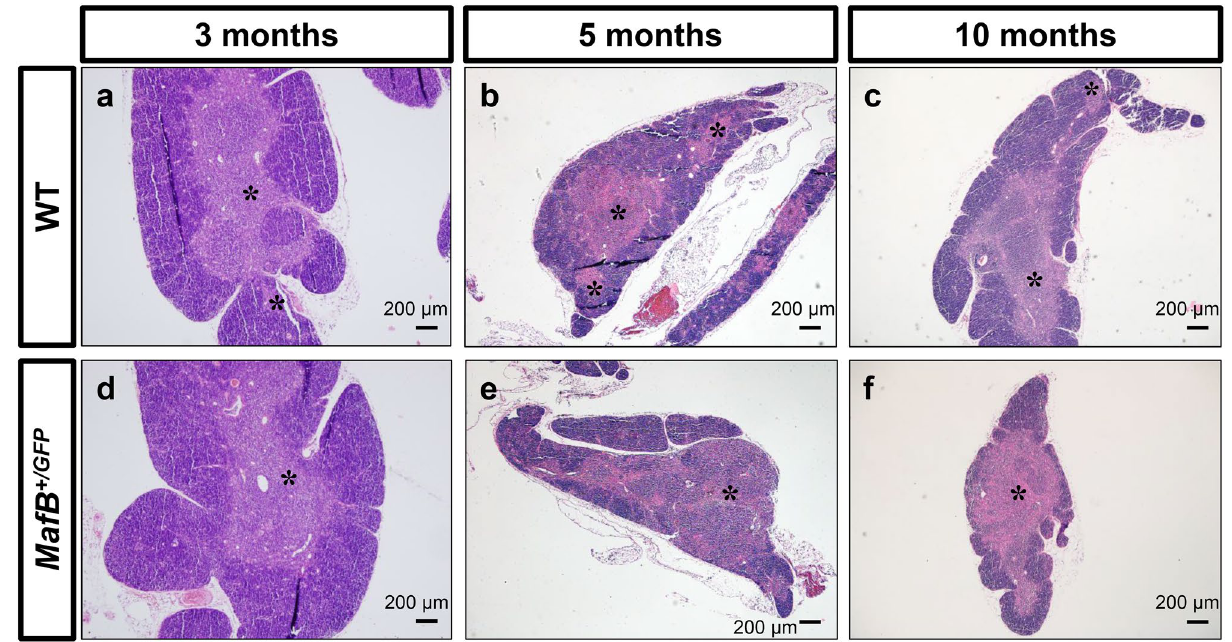
Figure 7. MafB + /GFP mice showed signs of accelerated age-related thymic involution. ( a – f ) Hematoxylin and Eosin (H.E.) staining of 3, 5 and 10-month-old MafB + /GFP and WT thymi paraffin sections (transverse). Scale bar: 200 µm. ( a , b ) 3 and 5-month-old WT thymi showed normal thymic architecture, judged by the presence of medullary region with a clear distinction between cortex (purple-colored regions) and medulla (pink-colored regions). Black asterisks indicate medullary region. ( c ) 10-month-old WT thymi displayed signs of age-related thymic involution, with slightly reduced number of medullary region and slight loss of distinction between cortex and medulla (relatively small intermixed pink and purple regions). ( a , d ) The thymi of 3-month-old MafB + /GFP mice were histologically similar to those of WT littermates. ( b , c , e , f ) The thymi of 5-month-old and 10-month-old MafB + /GFP mice exhibited slightly decreased number of medullary region compared to those of WT littermates. In contrast to WT counterparts, mutant thymi also displayed a greater loss of distinction between cortex and medulla, wherein a larger portion of the tissue area is occupied by medulla regions (pink) interspersed with cortex regions (purple). These observations suggest that MafB + /GFP thymi showed signs of accelerated age-related thymic involution compared to WT thymi. All data shown are representative results of 3 independent experiments using adult specimens from different litters (n =